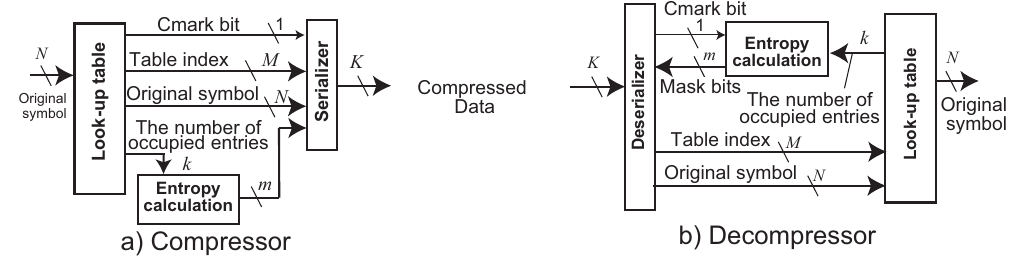
Figure 1. Organization of Compressor/Decompressor in ASE